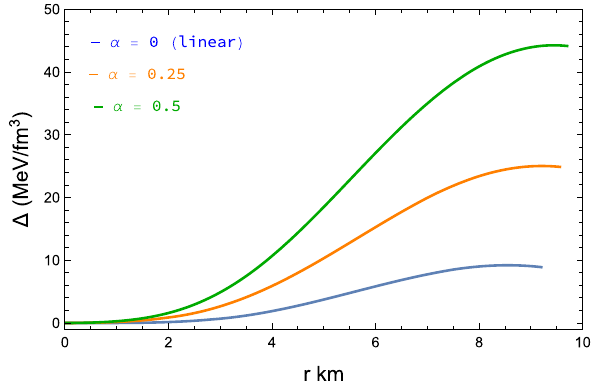
Fig. 3 Anisotropy